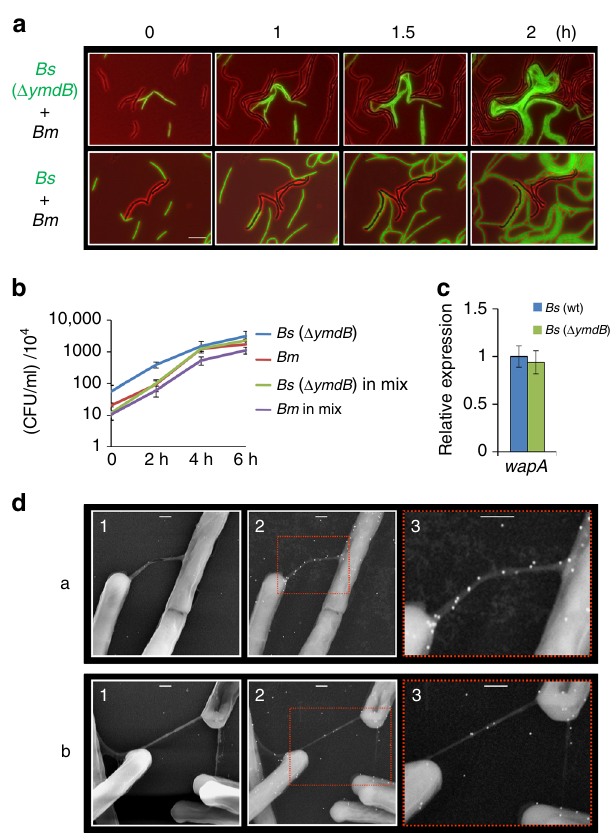
Fig. 3 ymdB mediates Bm inhibition by Bs . a Representative time-lapse microscopy images displaying a mixture of Bs (OS23: Δ ymdB, sacA:: P veg - mCherry ) and Bm (OS2) ( upper panels ), and a mixture of Bs (AR16: amyE:: P rrnE -gfp ) and Bm (OS2) ( lower panels ). Shown are overlay fl uorescence from mCherry or GFP ( green ) and phase contrast ( red ) images, captured at the indicated time points. Bm cells are shown in black while Bs cells are shown in green . Scale bar represents 10 µ m. b Bs (GB61: Δ ymdB ) and Bm (OS2) were grown separately or in a mixture in LB medium at 37 °C. Cells were plated for CFUs at the indicated time points. Bs and Bm were differentiated by colony morphology. Each point represents an average value and s.d. of three independent experiments. c RNA was isolated from Bs (PY79) and Bs (GB61: Δ ymdB ) cells grown to the mid logarithmic phase and expression of wapA was determined by qRT-PCR. Transcript levels are relative to Bs (PY79). Each bar represents an average value and s.d. of three independent experiments. d Bs (SH29): wapA-2 × HA, Δ ymdB, amyE:: P hyper-spank -ymdB, Δ hag ) cells harboring wapA -2xHA were spotted onto EM grids. Cells were subjected to immuno-gold HR-SEM using primary antibodies against HA and secondary gold-conjugated antibodies. Samples were not coated before observation. Shown are two examples of WapA- 2xHA localization ( white dots ) to nanotubes: intimate intercellular nanotube (a) and a nanotube network view b. HR-SEM images were acquired using TLD-SE (Through lens detector-secondary electron) (1) and vCD (low-kV high-contrast detector) (2). An enlargement of the boxed regions in (2) is shown in (3). Scale bars represent 200